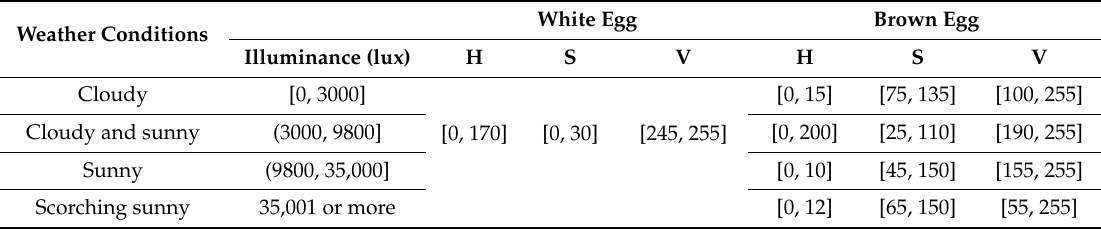
Table 2. Relationship between color threshold and light